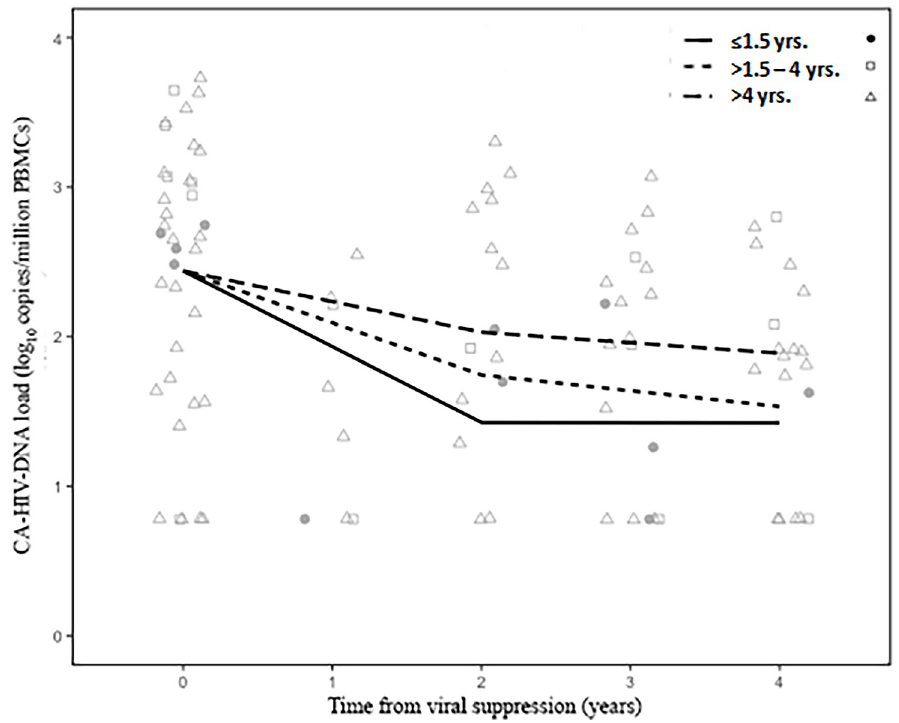
Fig 3. Decay rates of CA-HIV-DNA from children with sustained viral suppression according to the age of infection at VS. Individual lines indicate the trajectories of CA-HIV-DNA based on the model prediction. Individual points represent the quantification of HIV-1 DNA from each patient at specific time